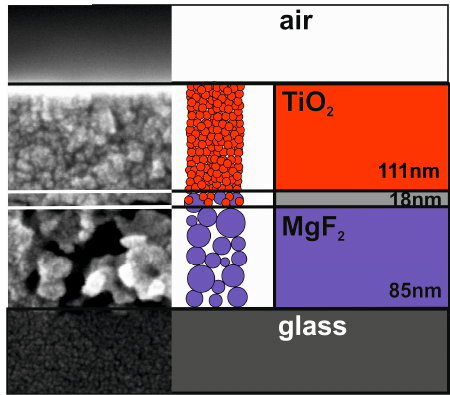
Figure 10. SEM image along with schematic representation of sol-derived TiO 2 film on top of porous MgF 2 layer. Based on [50].